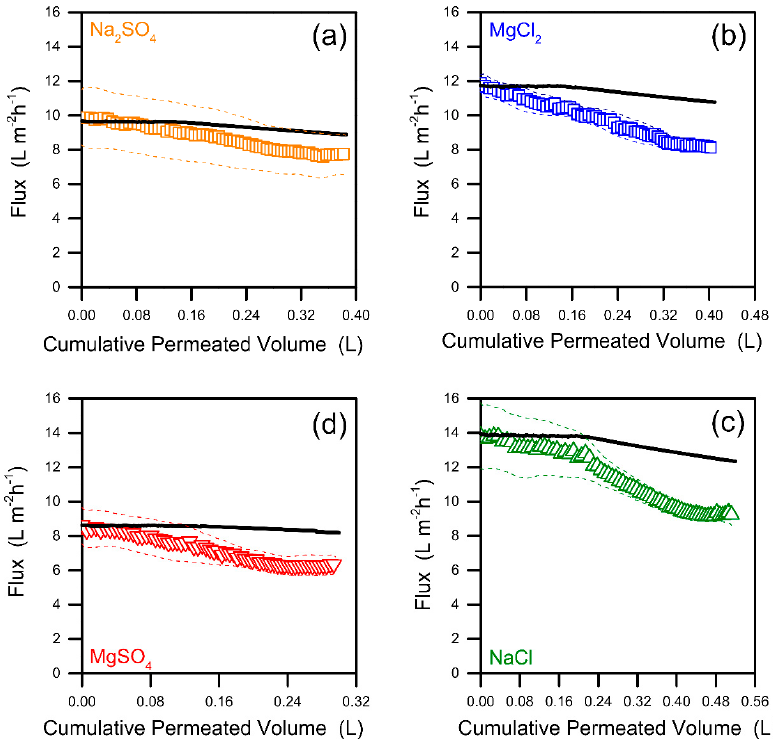
Figure 4. Results of the fouling experiments performed with ( a ) sodium sulfate, ( b ) magnesium chloride, ( c ) sodium chloride, and ( d ) magnesium sulfate as draw solutes, at initial draw osmotic pressure of 18.4 bar. The open points represent the average values of flux from duplicate or triplicate experiments. The dashed lines are the flux values with addition and subtraction of the standard deviation. The black lines depict the modeled fluxes, computed considering the sole reduction due to the loss of driving force in the batch tests, i.e., dilution of the draw and concentration of the feed solutions following water permeation.